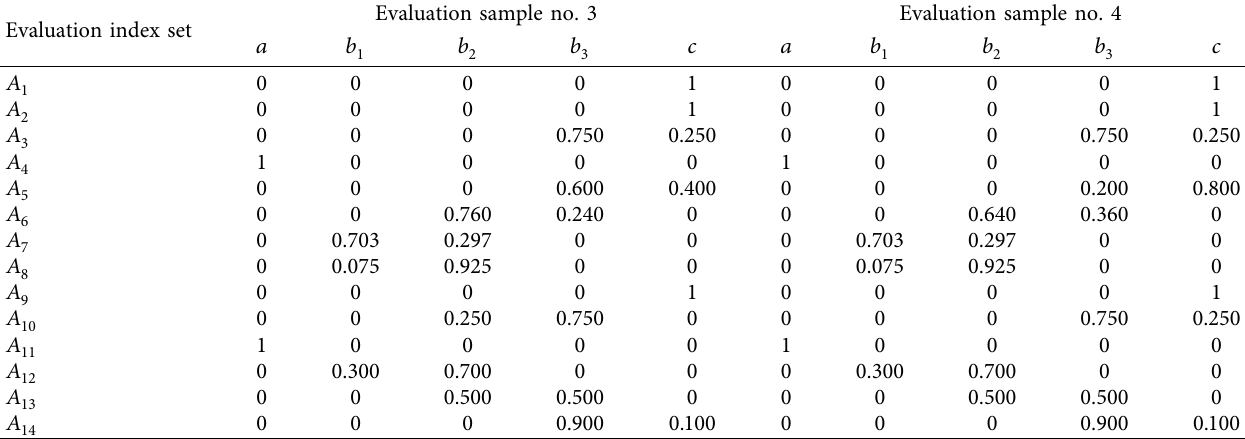
Table 7: Single-index connection degree of evaluation sample nos. 3 and 4.